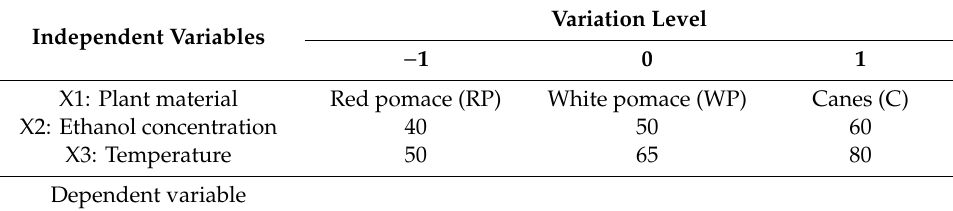
Table 1. Independent and dependent variables of the experimental